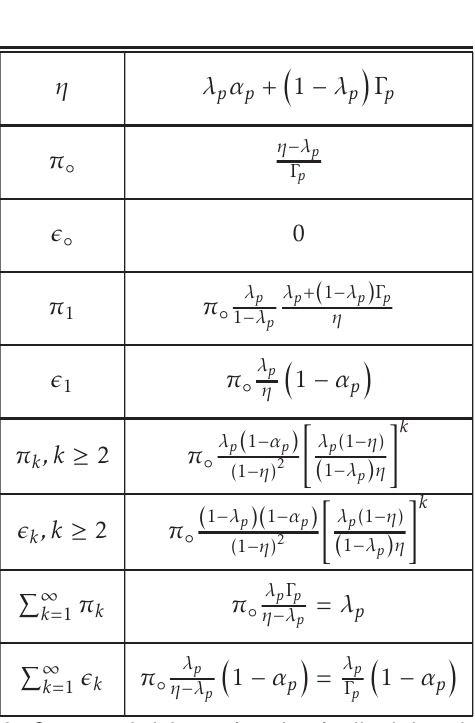
Table 2. State probabilities for the feedback-based access